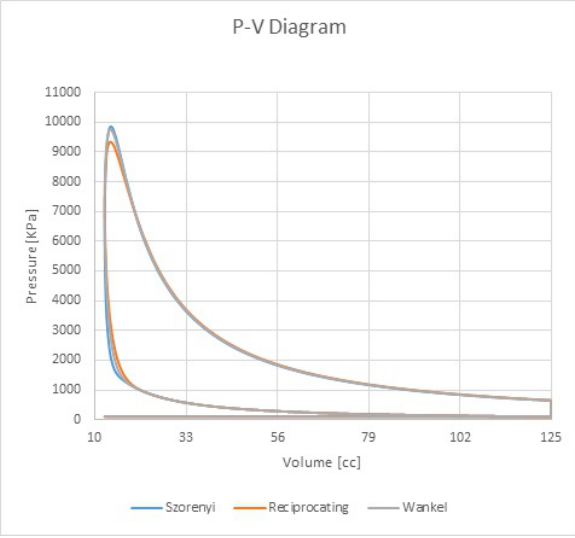
Fig. 8: P-V diagram comparison of Szorenyi, Wankel and Reciprocat- ing engine